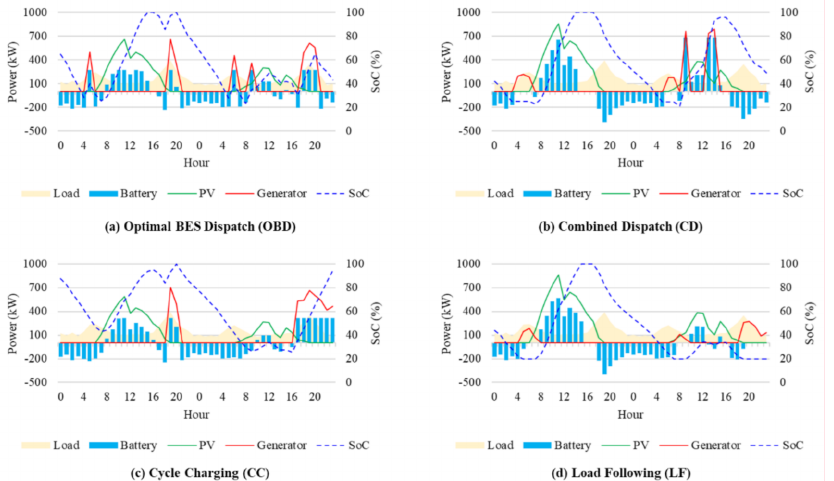
Figure 13. The operation pattern in System-2 for all control strategies in two consecutive days in September. BES was constantly discharged at the low load period, or every time there was a lack of supply from the PV